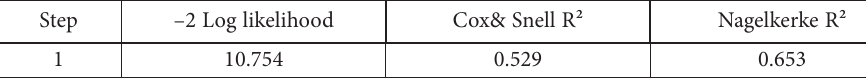
Table 14. The Goodness of Fit for the researched model